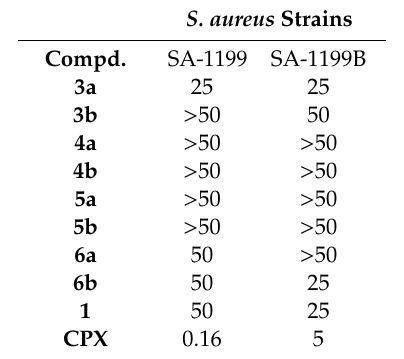
Table 1. MIC values ( µ g / mL) of derivatives 3a , 3b , 4a , 4b , 5a , 5b , 6a , 6b , the starting hit 1 and CPX against SA-1199 and